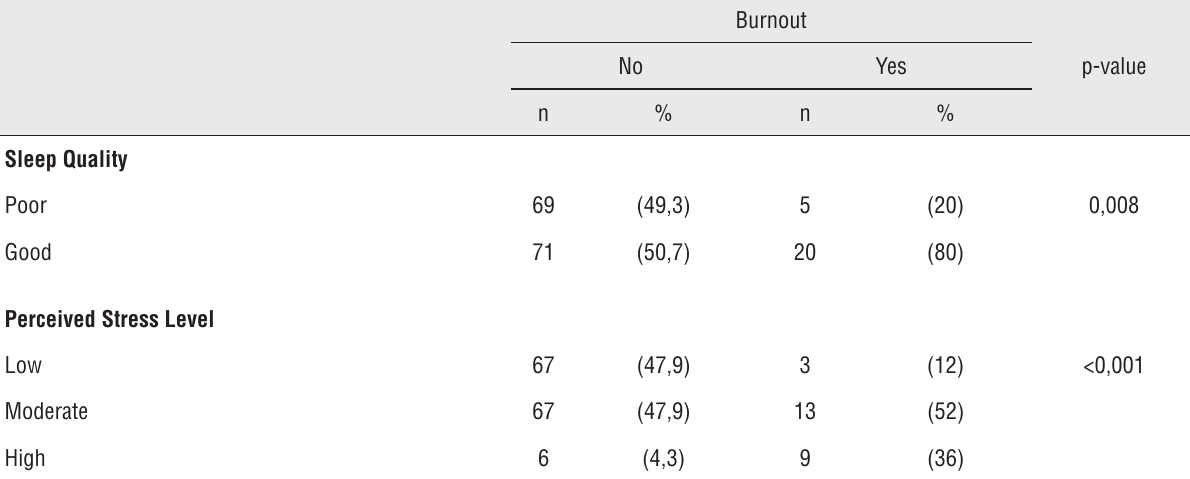
Table 1. Burnout distribution in relation to sleep quality and perceived stress level of Brazilian urologists during the COVID-19